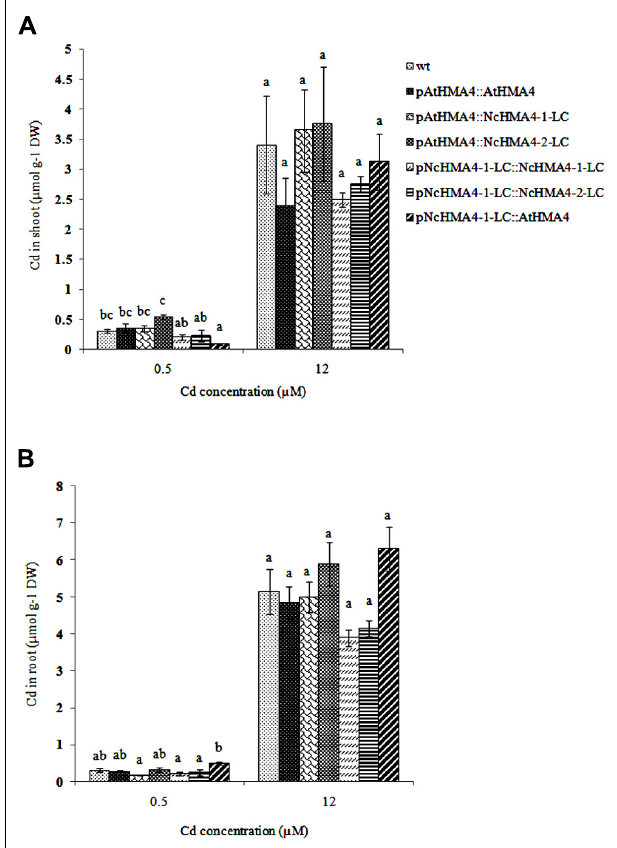
FIGURE 11 | Cd concentration in Arabidopsis wt and transgenic lines ( μ mol g -1 DW) exposed to 0. 5 and 12 μ M Cd. (A) shoot, (B) root. Significant differences ( P < 0.05) between means are indicated, separately for both treatments, by different superscripted